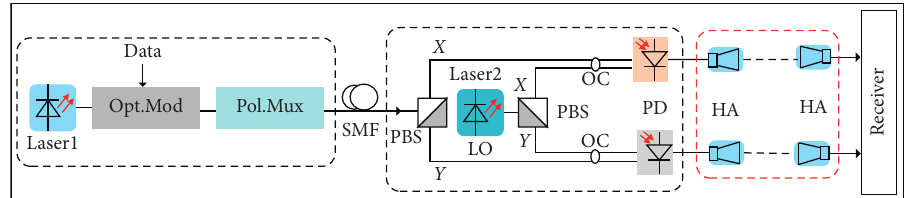
Figure 11: Structure diagram of optical PDM combined with MIMO. Pol.Mux, polarization multiplexer; LO, local oscillator; HA, horn antenna [52].